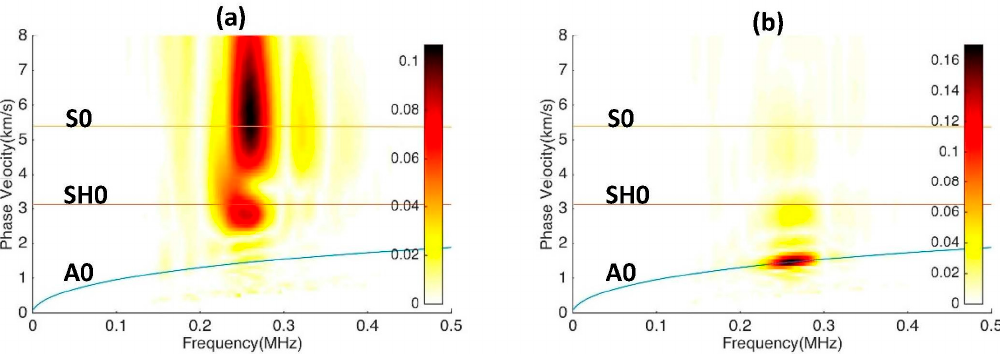
Figure 14. Experimental results for modal decomposition experiment. Signal windows are taken at ( a ) 60 to 150 µs and ( b ) 150 to 220 µs.